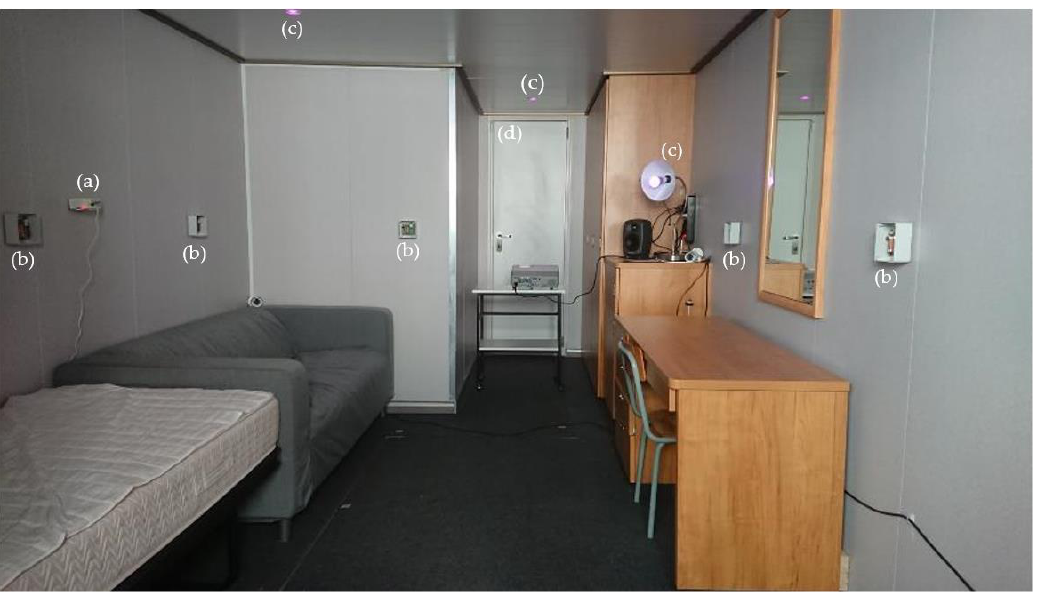
Figure 9. Inside view of the experimental cabin exposing some of the deployed sensors: ( a ) Noise sensor, ( b ) indoor localization anchors, ( c ) controllable light bulbs, and ( d ) door/movement/light sensor.